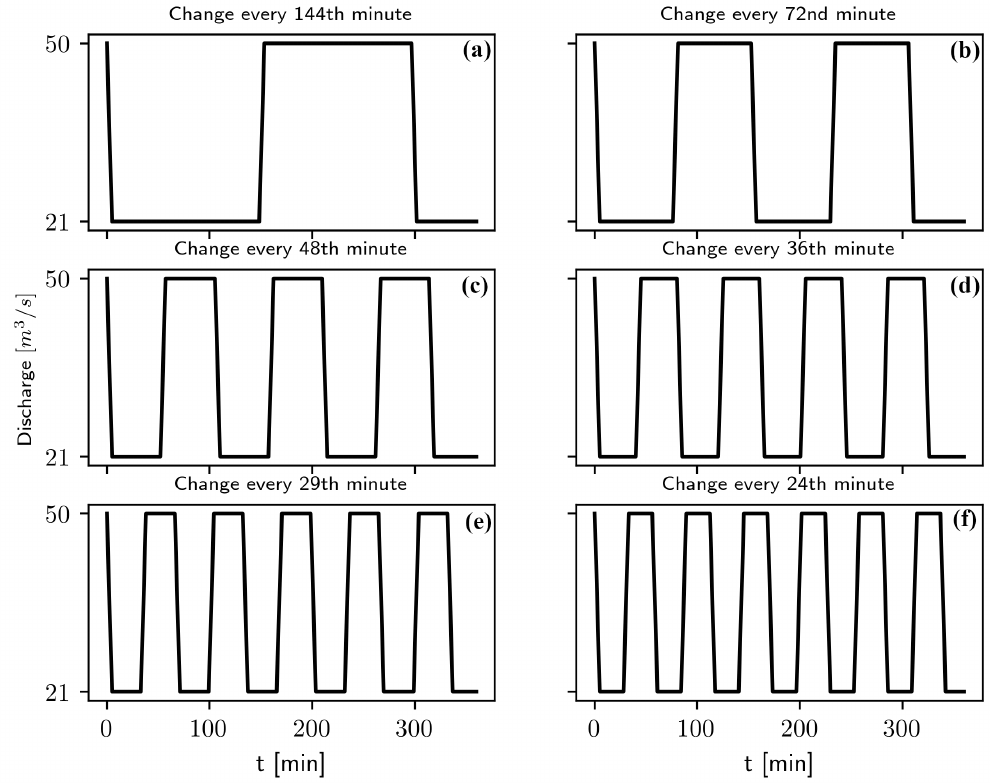
Figure 3. Hydrograph for the six different scenarios under consideration: ( a ) 10 flow changes per day. ( b ) 20 flow changes per day. ( c ) 30 flow changes per day. ( d ) 40 flow changes per day. ( e ) 50 flow changes per day. ( f ) 60 flow changes per